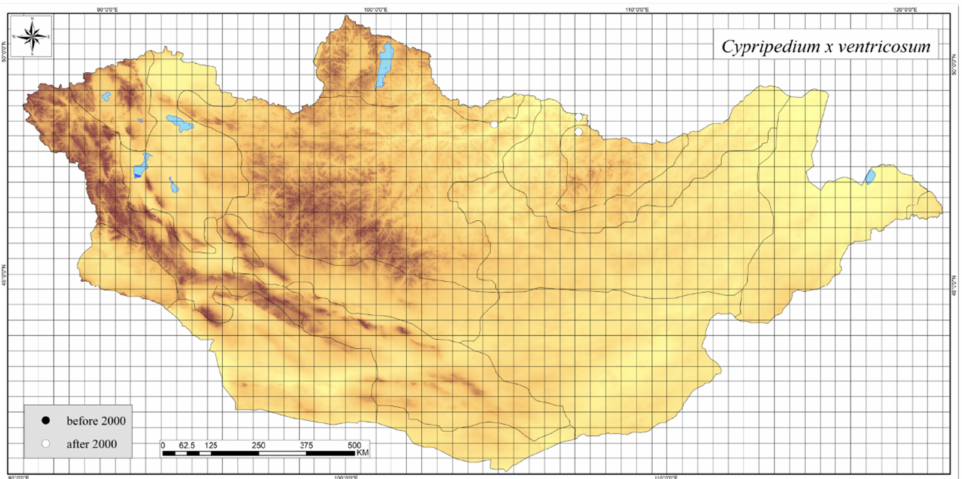
Figure A6. Distribution map of Cypripedium × ventricosum in Mongolia.